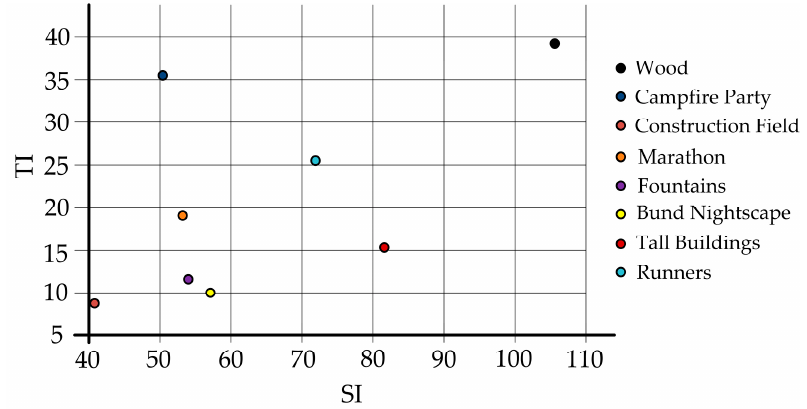
Figure 3. Spatial information (SI) and temporal information (TI) values for UHD video sequences [19].